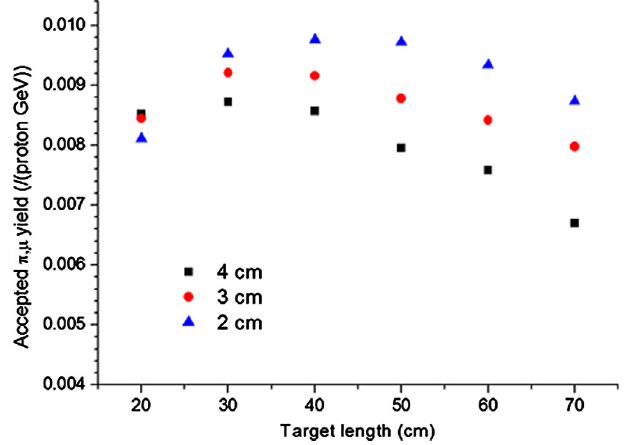
FIG. 10. Desired (pions and) muons yields (per proton per GeV) of 8 GeV proton beam for different target widths for the neutrino factory as a function of target